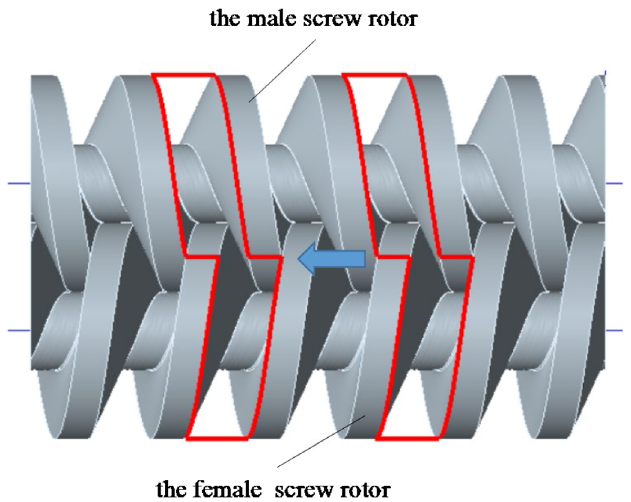
Fig. 1. Fixed pitch screw vacuum pump.